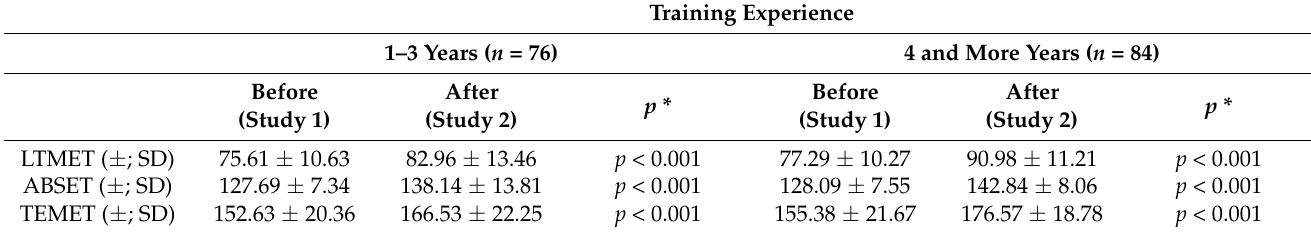
Table 4. Results of the core stability tests before and after core stability training, sorted by training experience.